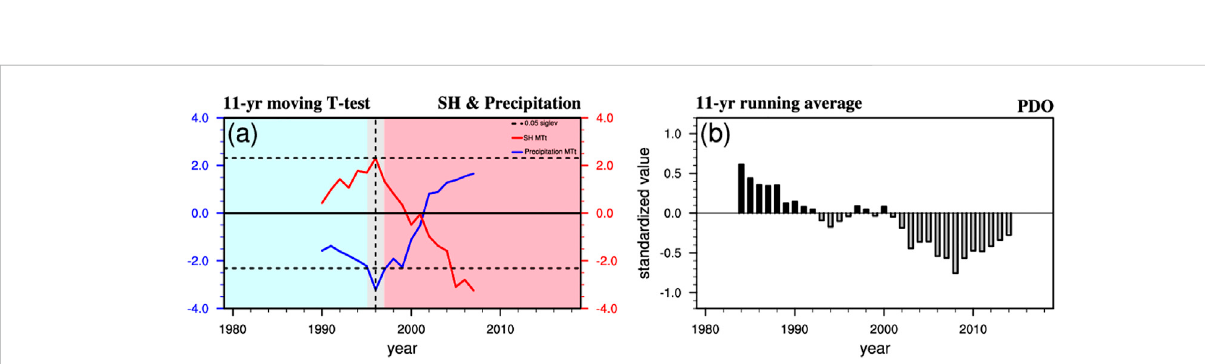
TABLE 1 Remarkable spring SH over the TP and ENSO events in Niño-3 based on the different PDO phases during 1979 – 2019. T1: PDO